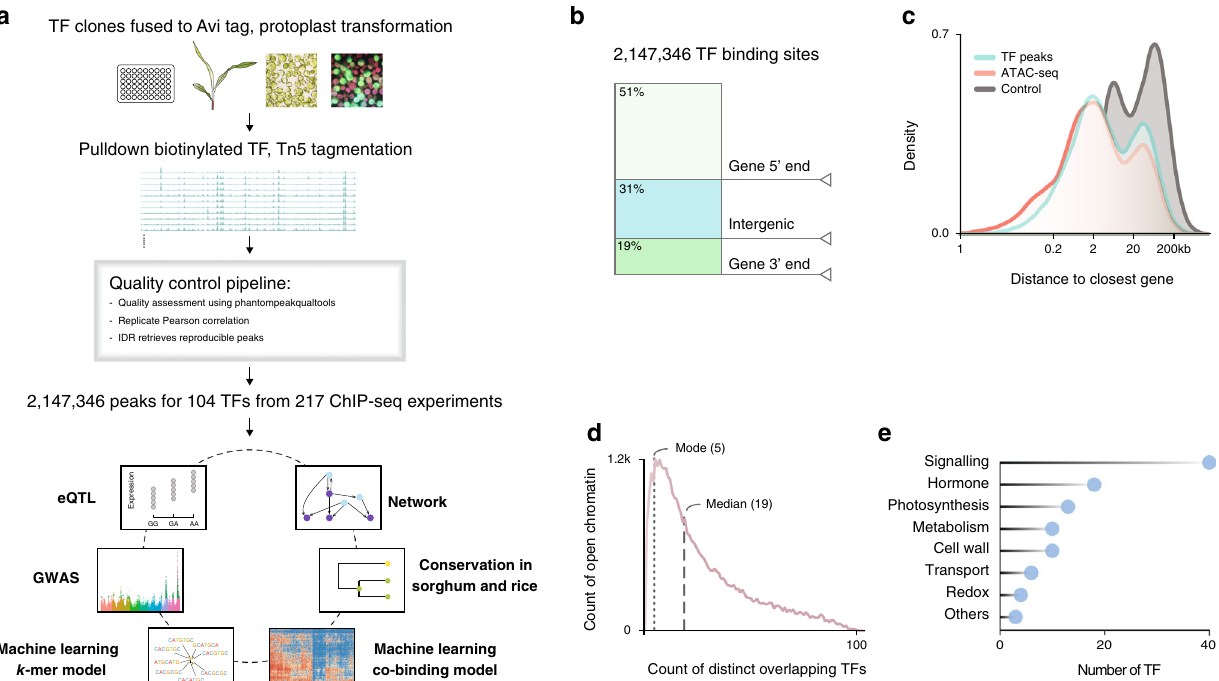
Fig. 1 The transcription regulatory landscape of the maize leaf. a Overview of the experimental and analytical approaches. b Genome-wide distribution of TF-binding loci. c Density plots corresponding to distances of TF-binding sites (green) and open chromatin regions (red) to closest annotated gene. Gene- to-gene distant is used as a control (gray). d Distribution of the number of TFs-binding sites in open chromatin region. e Functional classi fi cation of the 104 TF based on their target genes. The height of the bar indicates the number of TF associated with each MapMan